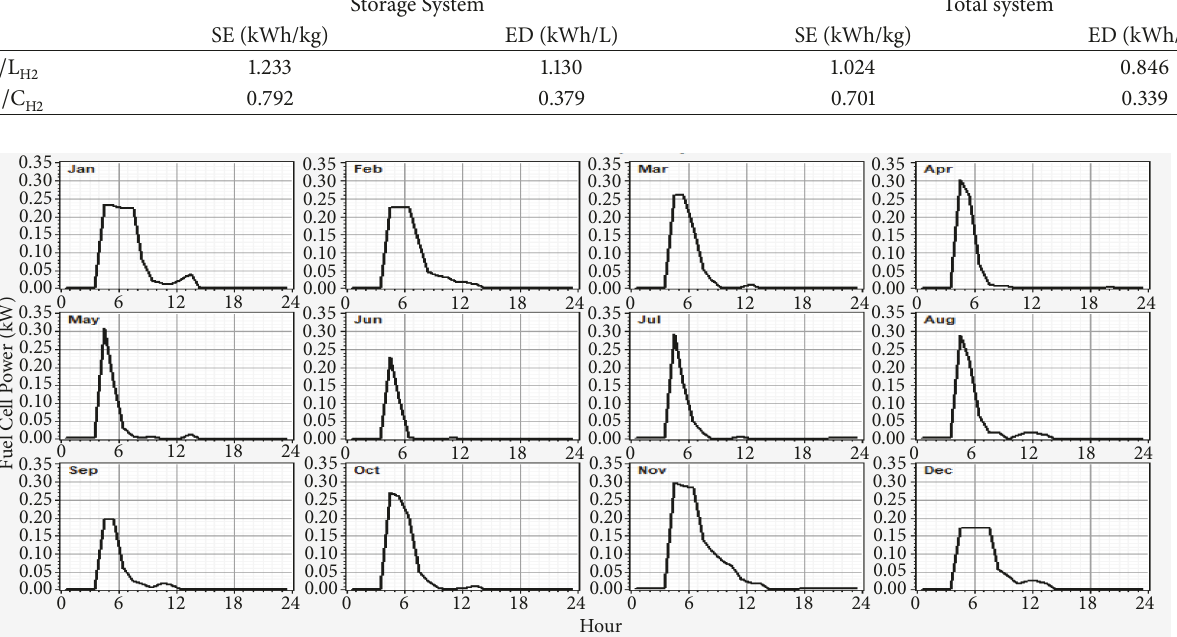
Figure 19: The fuel cell power profile.